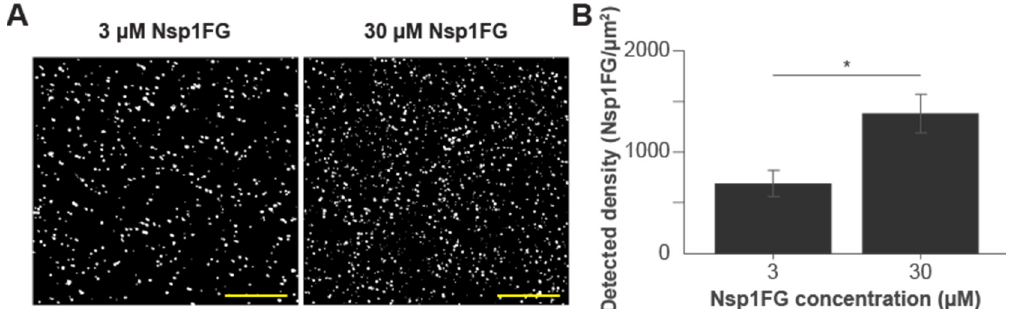
Figure 1. Average detected surface density of Nsp1FGs. Activated glass coverslips were incubated (at 3 µ M or 30 µ M) with one of three variants of Nsp1FG. ( A ) Representative ROIs showing localizations of Nsp1FG12-AF647. Scale bar, 5 µ m. ( B ) The average detected density for Nsp1FG surfaces at 3 µ M incubating concentration ( n = 30 ROIs, 6 independent measurements for Nsp1FG5, Nsp1FG12, and Nsp1FG18) and at 30 µ M incubating concentration ( n = 30 ROIs, 6 independent measurements for Nsp1FG12 and Nsp1FG18); * p ≤ 0.02. Error bars represent SEM.